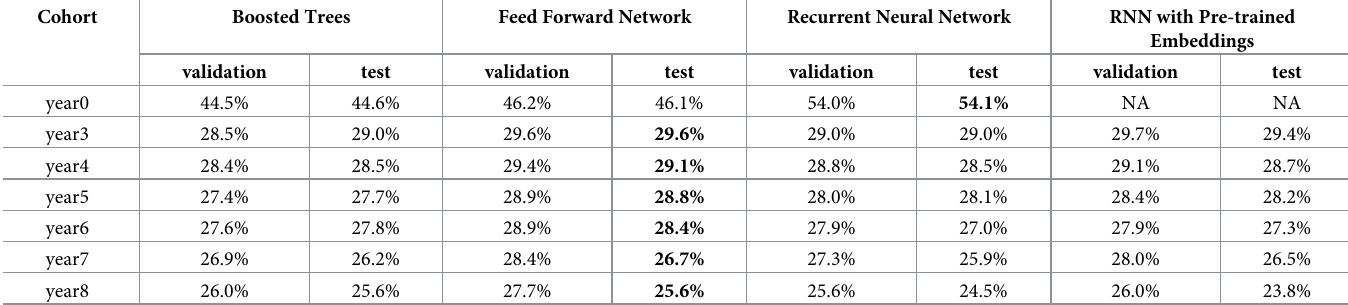
Table 3. F1 scores for validation and test cohorts using different models computed using prevalence in the validation cohort. Cohort